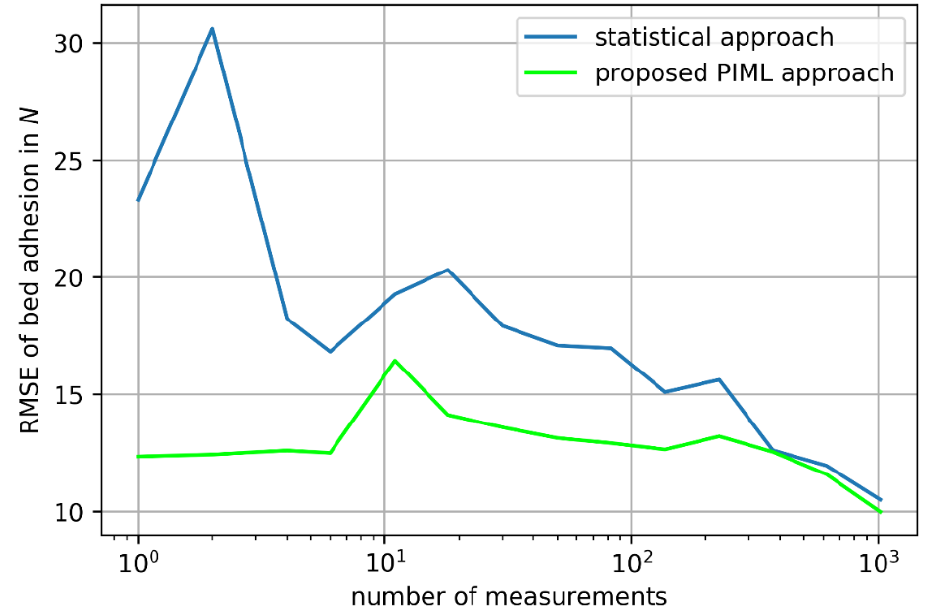
Figure 9. Comparison of prognosis error of print bed adhesion between the proposed PIML approach and a statistical approach using a similar DNN and identical training data and test data.